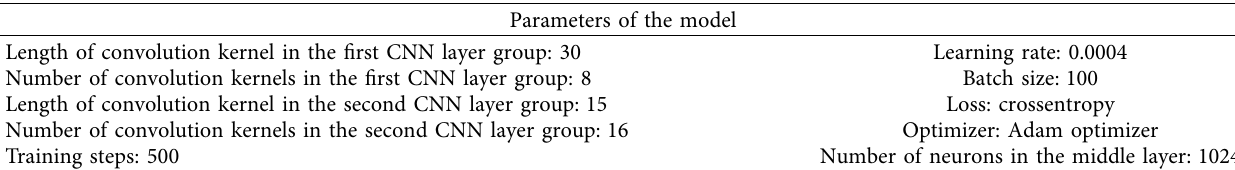
Figure 5: Te vibration signals of four armored vehicles. (a) Vibration signal of armored vehicle 1, (b) vibration signal of armored vehicle 2, (c) vibration signal of armored vehicle 3, and (d) vibration signal of armored vehicle 4. Table 1: Structure parameters of improved CNN.